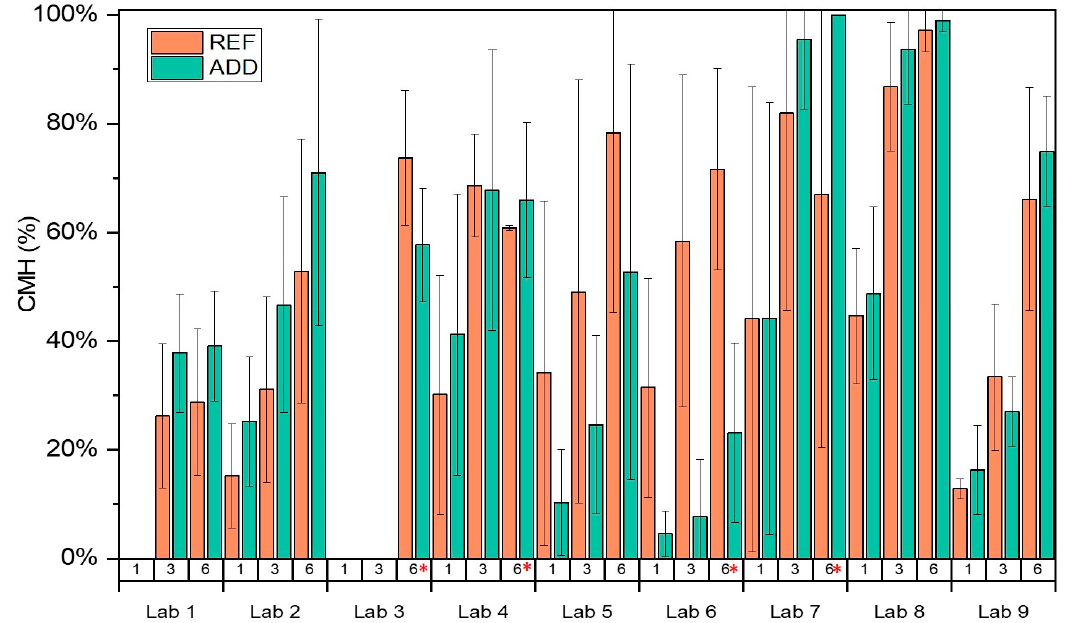
Figure 8. The crack healing CMH measured in the different labs. * denotes healing periods longer than the specified 6 months. Experimental work was delayed due to COVID restrictions.